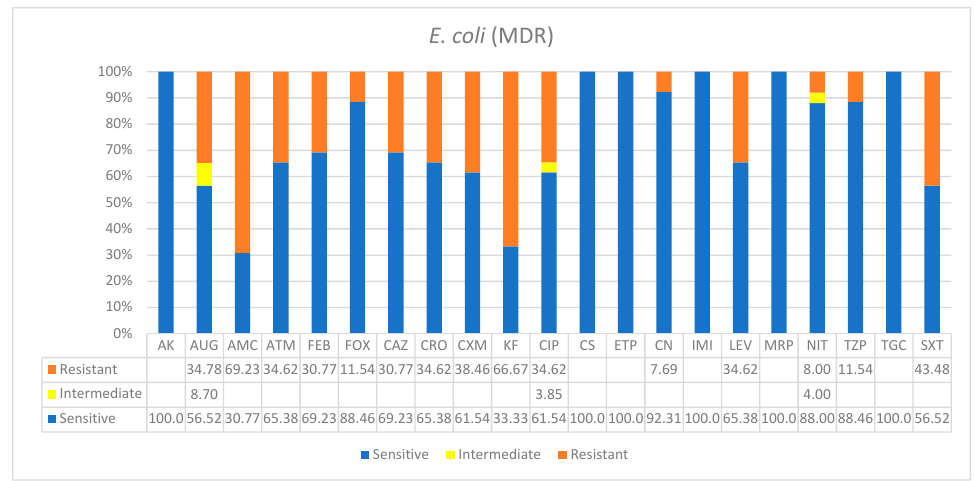
Figure 3. Antimicrobial sensitivity patterns of E. coli clinical isolates against 21 antibiotics. Abbrevia- tions (in the order in which they appear in the figure): AK, amikacin; AUG, amoxicillin/clavulanic acid (2/1); AMC, ampicillin; ATM, aztreonam; FEP, cefepime; FOX, cefoxitin; CAZ, ceftazidime; CRO, ceftriaxone; CXM, cefuroxime; KF, cephalothin; CIP, ciprofloxacin; CS, colistin; ETP, ertapenem; CN, gentamicin; IMI, imipenem; LEV, levofloxacin; MRP, meropenem; NIT, nitrofurantoin; TZP, tazobactam; TGC, tigecycline; SXT, trimethoprim/sulfamethoxazole. Pseudomonas aeruginosa caused 8.5% of overall infections in this study. These were mostly from sputum specimens and swabs of respiratory tract and wound infections collected in the ICU and COVID-19 wards (Table 1). The antimicrobial susceptibility of P. aeruginosa showed a balanced pattern. Albeit it was classified as XDR based on recent drug classification guidelines, an almost equal number of drugs were found highly effective against this organism in in vitro assays. For instance, full resistance to the following antibiotics was observed: AUG, FOX, CRO, CXM, ETP, and TGC. However, higher levels of susceptibilities were observed in cephalothin (80%), ampicillin (86.6%), cefepime (85.7%), ceftazidime (80%), colistin (93.3%), and 73.3% each for gentamicin and imipenem (Figure 4)